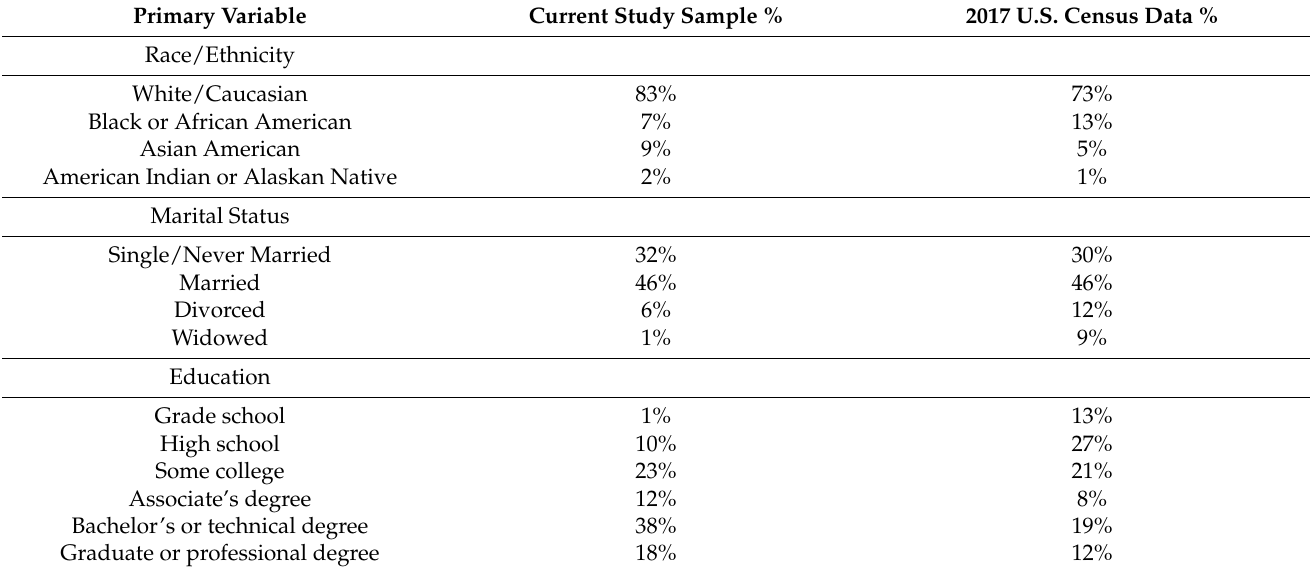
Table 1. Sociodemographic